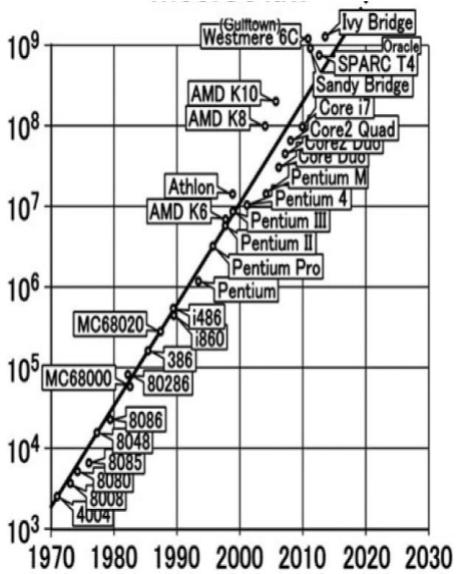
Figure 2. Moore's Law predicts exponential growth of ICs since 1970 (after